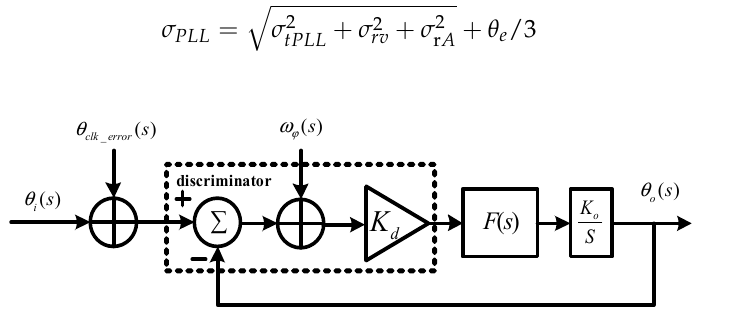
Figure 3. Error transfer model of stand-alone phase-locked loop (PLL).